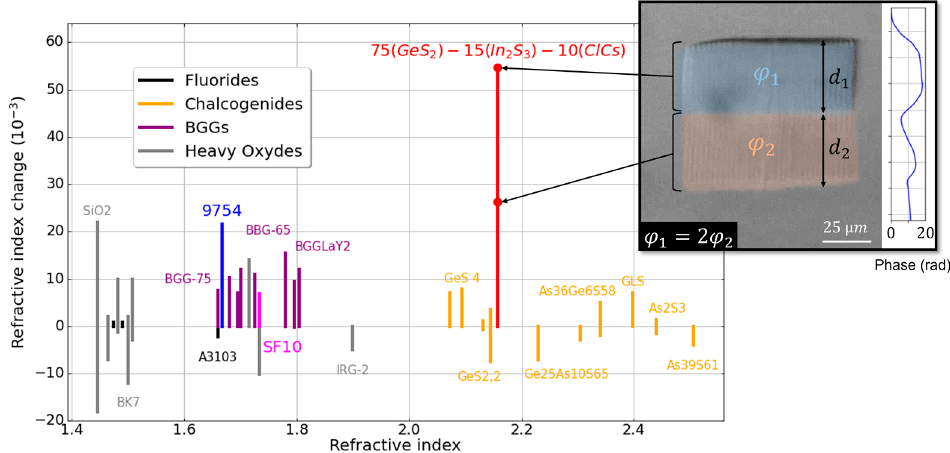
Figure 4. Range of refractive index variation induced by fs-laser vs. refractive index (typ. Measured at 550 nm) for different glasses. Our materials: GeS 2 in red, Corning 9754 in blue, and Schott SF10 in pink. Inset: a false color image of a textured disc profile showing the two sections of the phase and the associated phase profile along the cross-section.